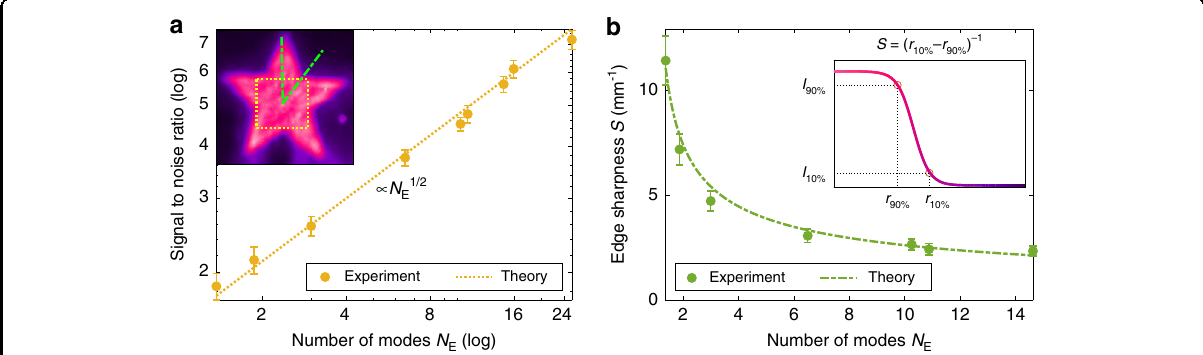
Fig. 4 Quantitative assessment of a meta-holographic image quality. a Intensity signal to noise ratio (SNR) of a star image (inset) within the central square (marked by a yellow dotted line in the inset) versus the effective number of spatial modes N E in illumination. Yellow circles are experimental data obtained by averaging the SNR over holographic images created by fi ve meta-holograms. The error bars represent the standard deviation of the SNR. The data points follow the dotted yellow line with a slope of 1/2 in logarithmic scales, indicating that the SNR scales as N 1 = 2 . b Edge sharpness S as a function of the number of spatial modes N E . Green circles represent experimentally measured S , averaged E over multiple edges of fi ve holographic images. The error bars represent the standard deviation of S . The dotted-dashed green line denotes the theoretical prediction of our model. The inset illustrates how S is extracted from the 1D intensity pro fi le across an edge (marked by a dotted- dashed green line in the inset of a